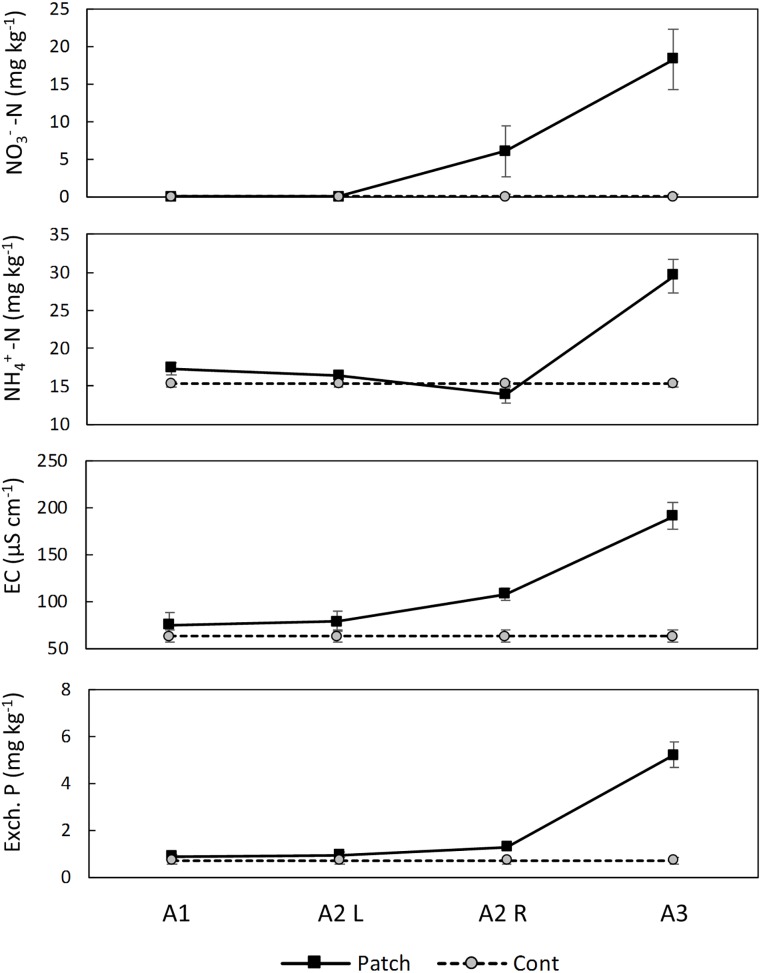
Soil analysis in the Ah horizon of the rhizoboxes at the end of the experiment. Quadrat A2 was divided to be able to detect a gradient. A3 is the quadrat where the patch of biosolids was located. Results represent average and standard errors (n = 6). EC, electrical conductivity.